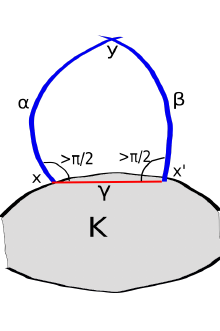
Figure 5 . A pair of geodesic rays α, β normal to a convex subset K cannot intersect, because the sum of the angles of triangle xx 0 y would be greater than π